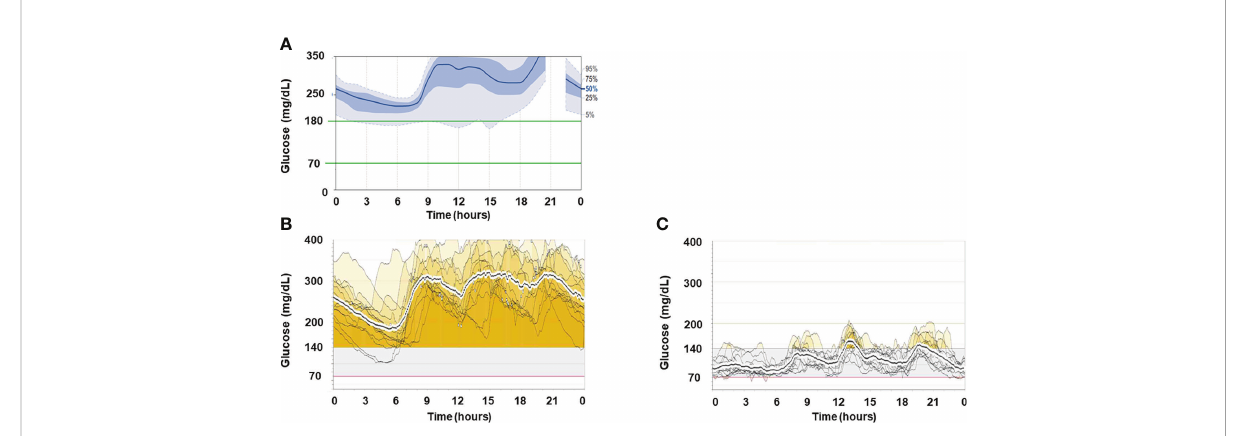
FIGURE 2 Representative glucose pro fi les of CGM recordings. (A) Representative ambulatory glucose pro fi le recorded by isCGM before treatment. (B) Two-week glucose pro fi les recorded by rtCGM one month after the initiation of treatment. (C) Two-week glucose pro fi les recorded by rtCGM nine months after the initiation of